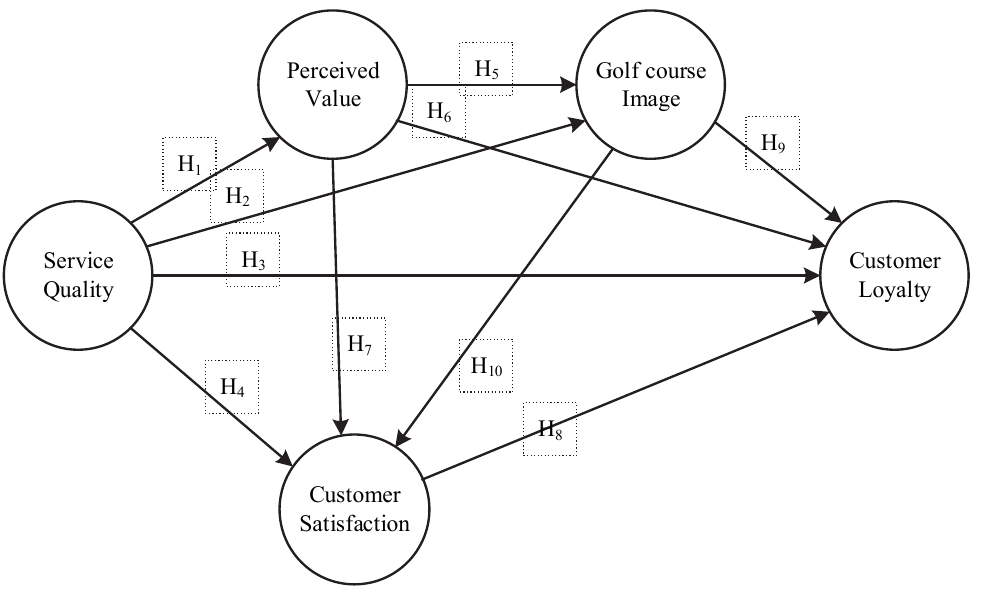
Fig. 1. Model examining the impacts of key factors on customer loyalty to golf